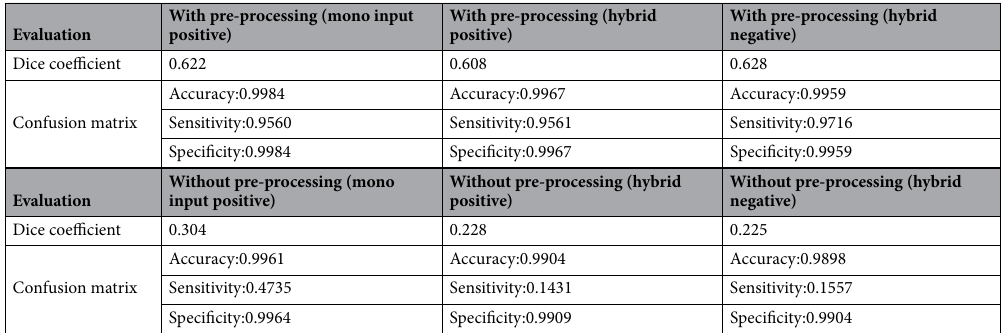
Table 3. The comparison in small data quantity (50 cases) of different method in lung nodule segmentation.